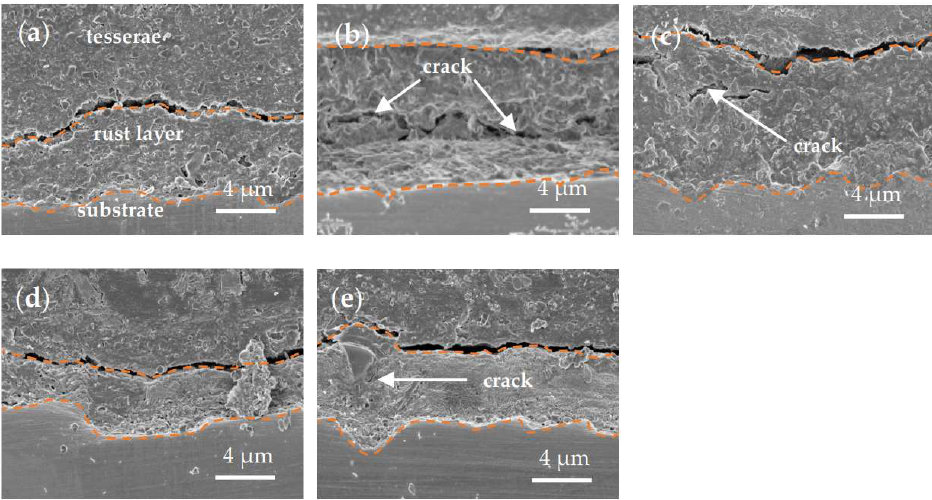
Figure 6. SEM images of the cross-section of the rust layer: ( a ) 48 h in 3.5% NaCl; ( b ) 144 h in 3.5% NaCl; ( c ) 288 h in 3.5% NaCl; ( d ) 144 h in 2.0% NaCl; and ( e ) 144 h in 5.0% NaCl.